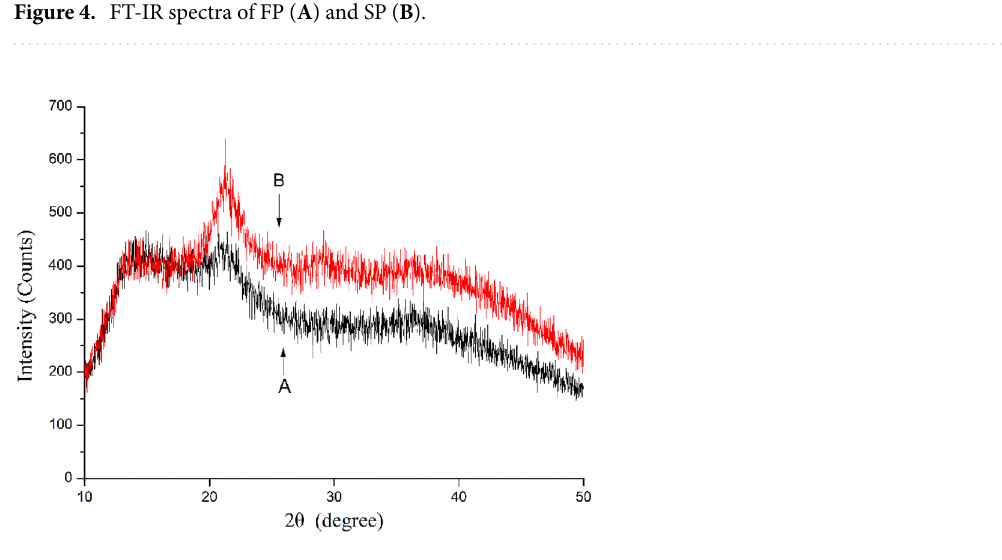
Figure 5. XRD of the FP ( A ) and SP ( B